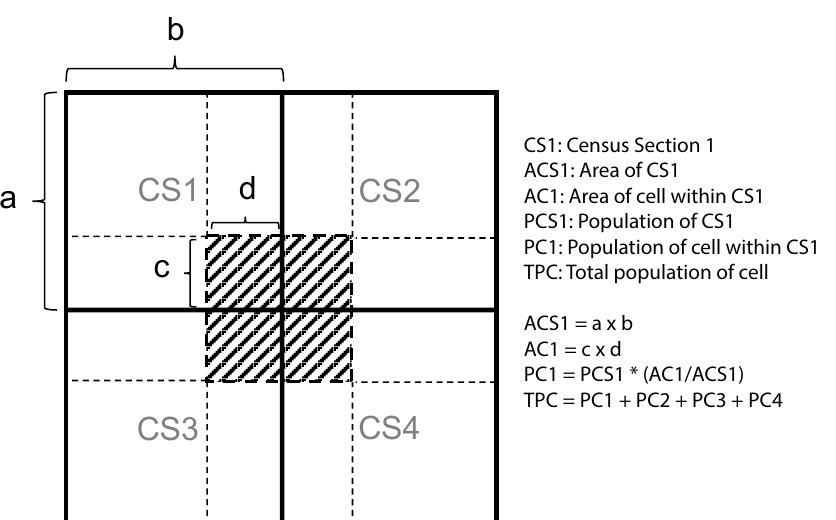
Figure 1 . Subdivision of census sections into regular cells and estimation of the population of a given cell (square with diagonal stripes) belonging to several census